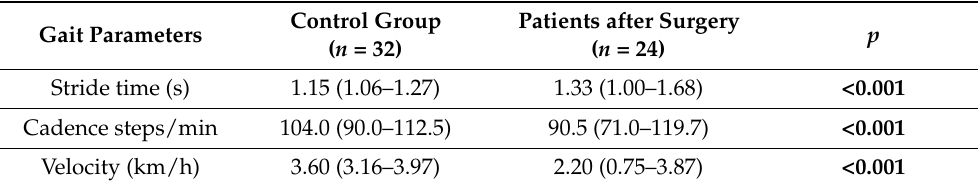
Table 2. Differences of gait parameters between control healthy group and patients after Ilizarov method therapy. Gait Parameters